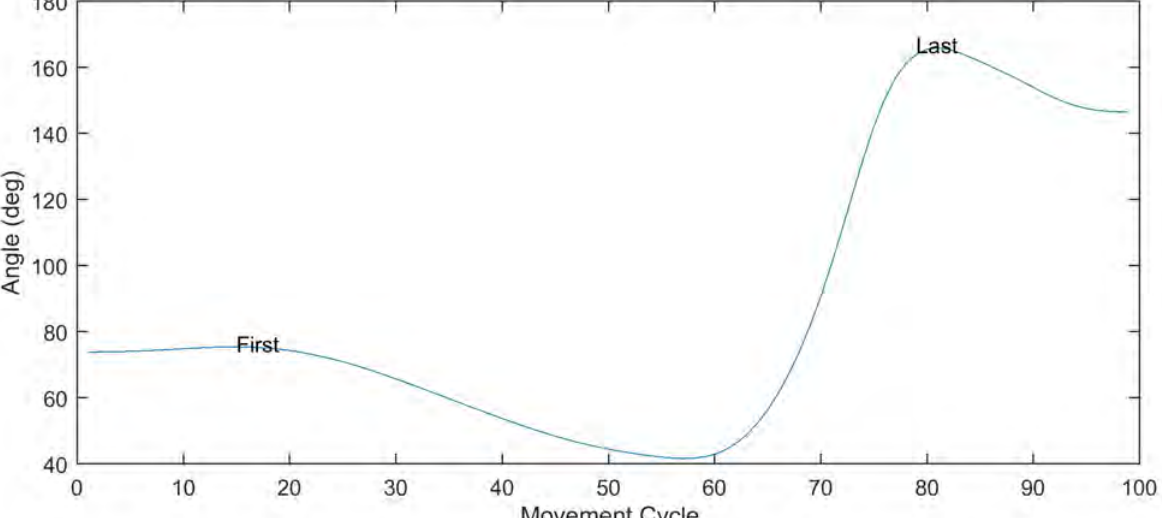
Figure 1. Time window sample for each throw that used to extract kinematic variables and relative timing landmarks according to the first peak and the last peak of the throw curve